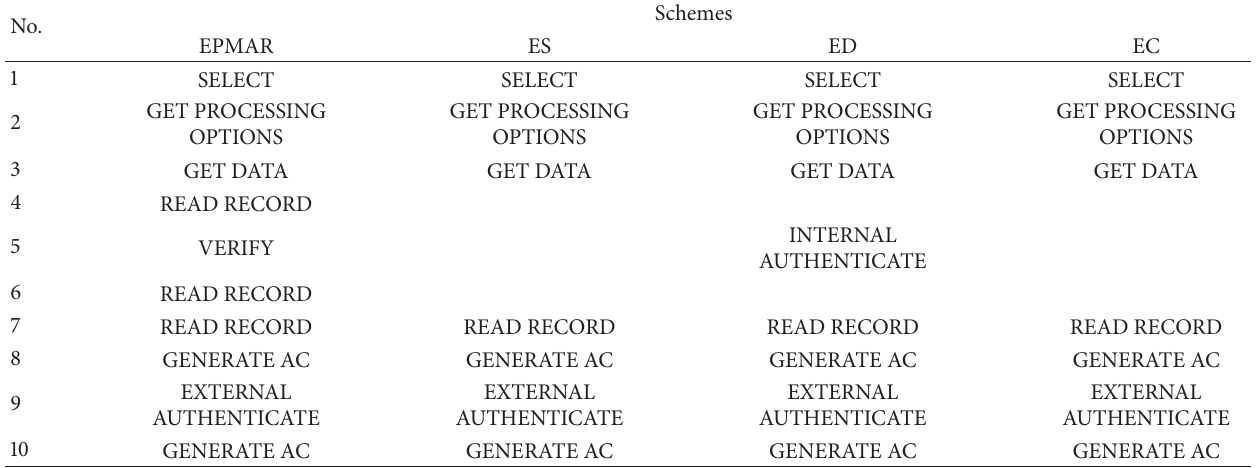
Table 5: Comparison of the number of messages with EMV.